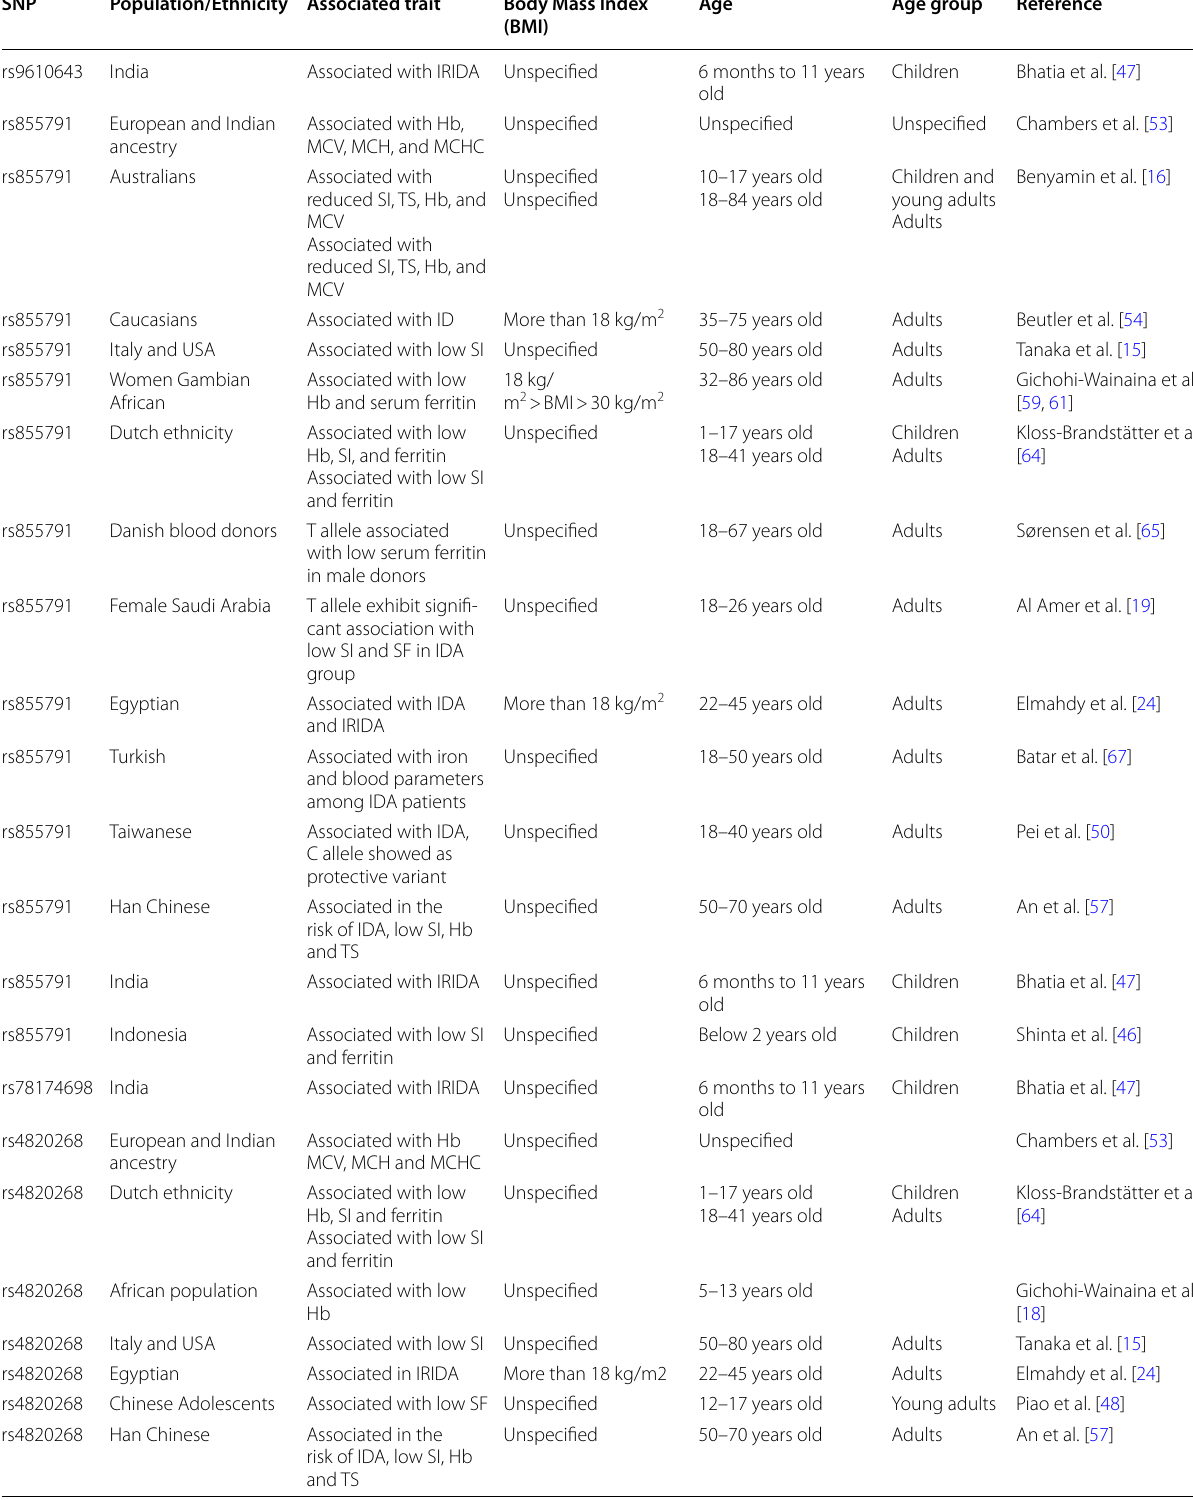
Table 1 List of identified SNPs in the TMPRSS6 gene across global population. (Location: Line 390) SNP Population/Ethnicity Associated